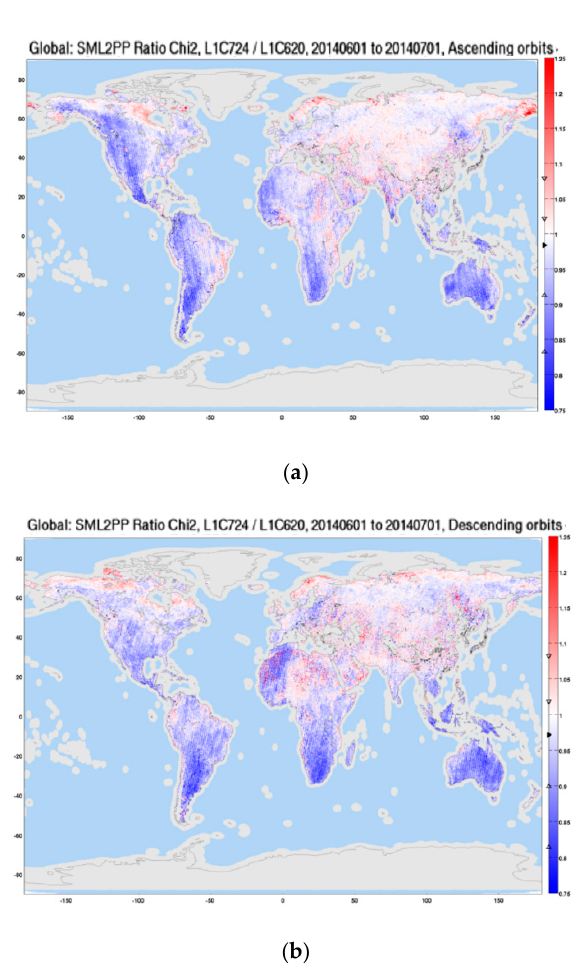
Figure 20. Maps of averaged χ 2 r ratios v724 / V620 for the month of June 2014 for ascending orbit ( a ) and descending orbit ( b ). Blue indicates that v724 improves with lower χ 2 compared to v620’. The markers located on the colour bar show the distribution variables, the mode is represented by the marker. The 68.3% and 95.4% percentiles are shown by the inner and outer markers, respectively.